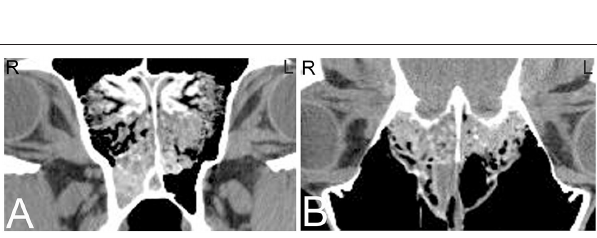
FIGURE 13 | Progressive ethmoid hematoma. Computed tomography images of the head of a 10-year-old Warmblood gelding with a history of right-sided nasal hemorrhagic and purulent discharge. Transverse (A) and dorsal (B) CT images at the level of the cribriform plate reveal a large, minimally contrast enhancing mass at the right and to a lesser extent left ethmoid turbinates with extension into the spheno-palatine sinus, and multifocal regions of destruction of the cribriform plate; which is most consistent with an ethmoid hematoma or neoplasia. Histopathology confirmed an invasive ethmoid hematoma. L, left; R,